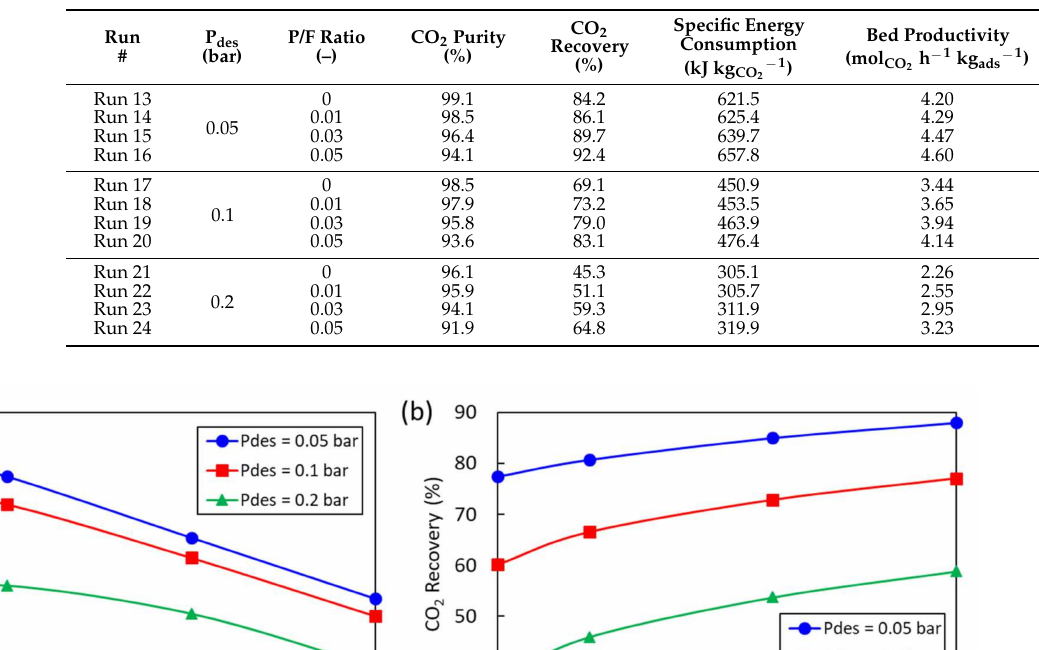
Table 4. Performance results of the 2-bed, 4-step VPSA process.